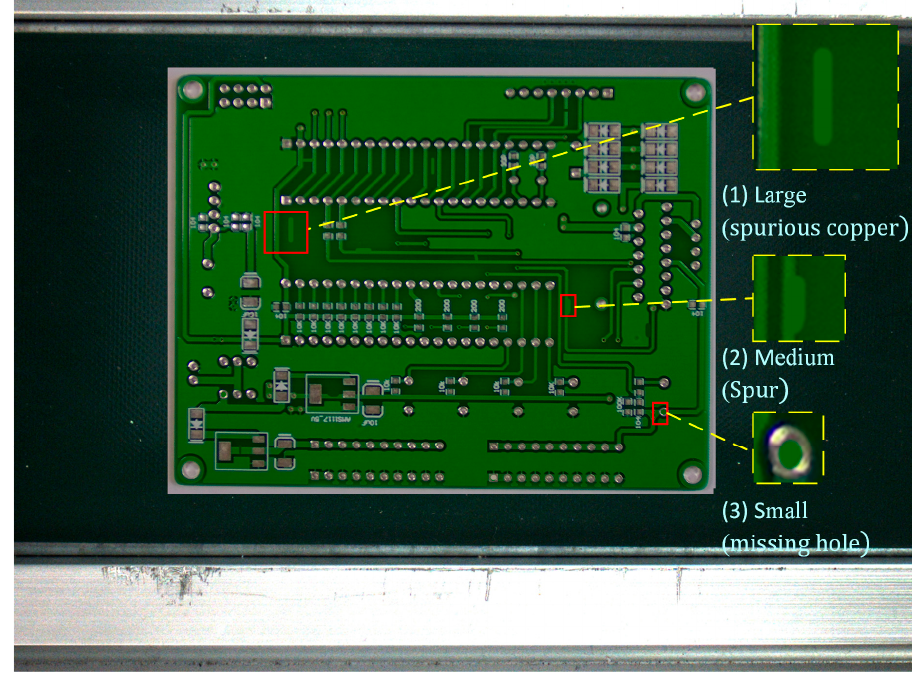
Figure 5. Details of the small, medium, and most